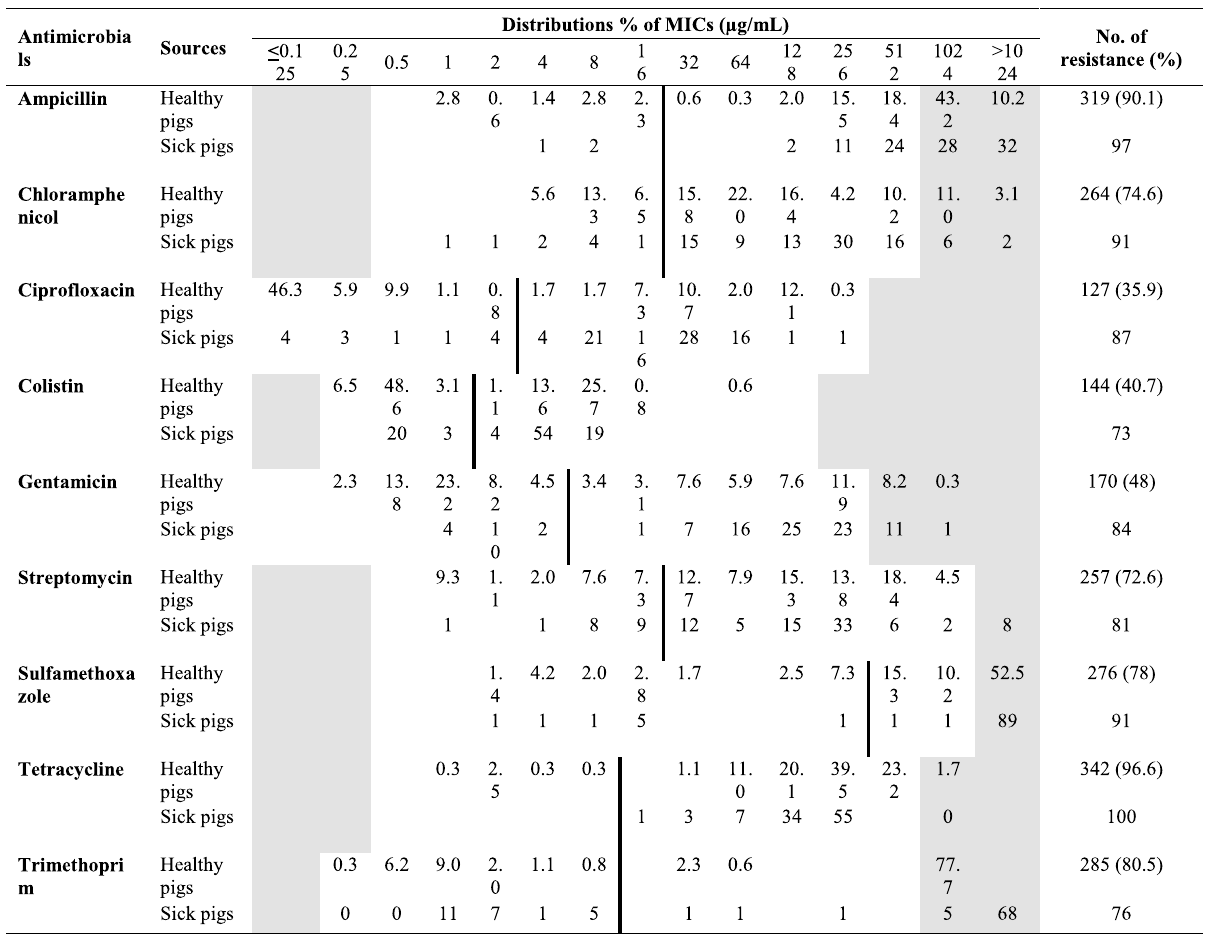
Table 1. Distribution of Minimum Inhibitory Concentrations (MICs) and resistance percentages for the E. coli isolates from healthy pigs (n = 354) and sick pigs (n = 100). White fields represent range of serial dilutions tested for each antimicrobial. The MICs higher than the highest concentration tested are provided as the concentration closest above the range. The clinical breakpoints for each antimicrobial are presented as a vertical line.